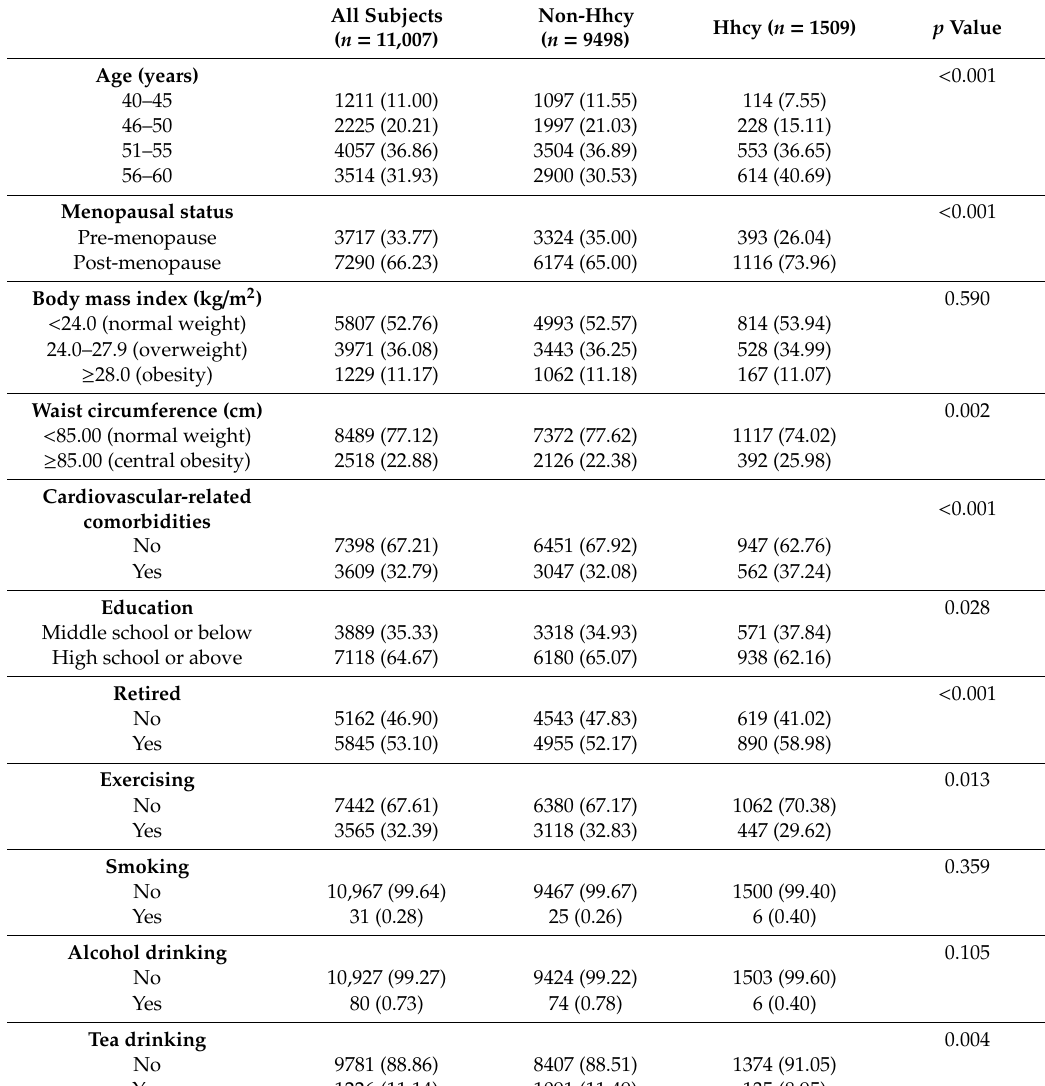
Table 1. Distributions of study variables among participants with and without hyperhomocysteinemia